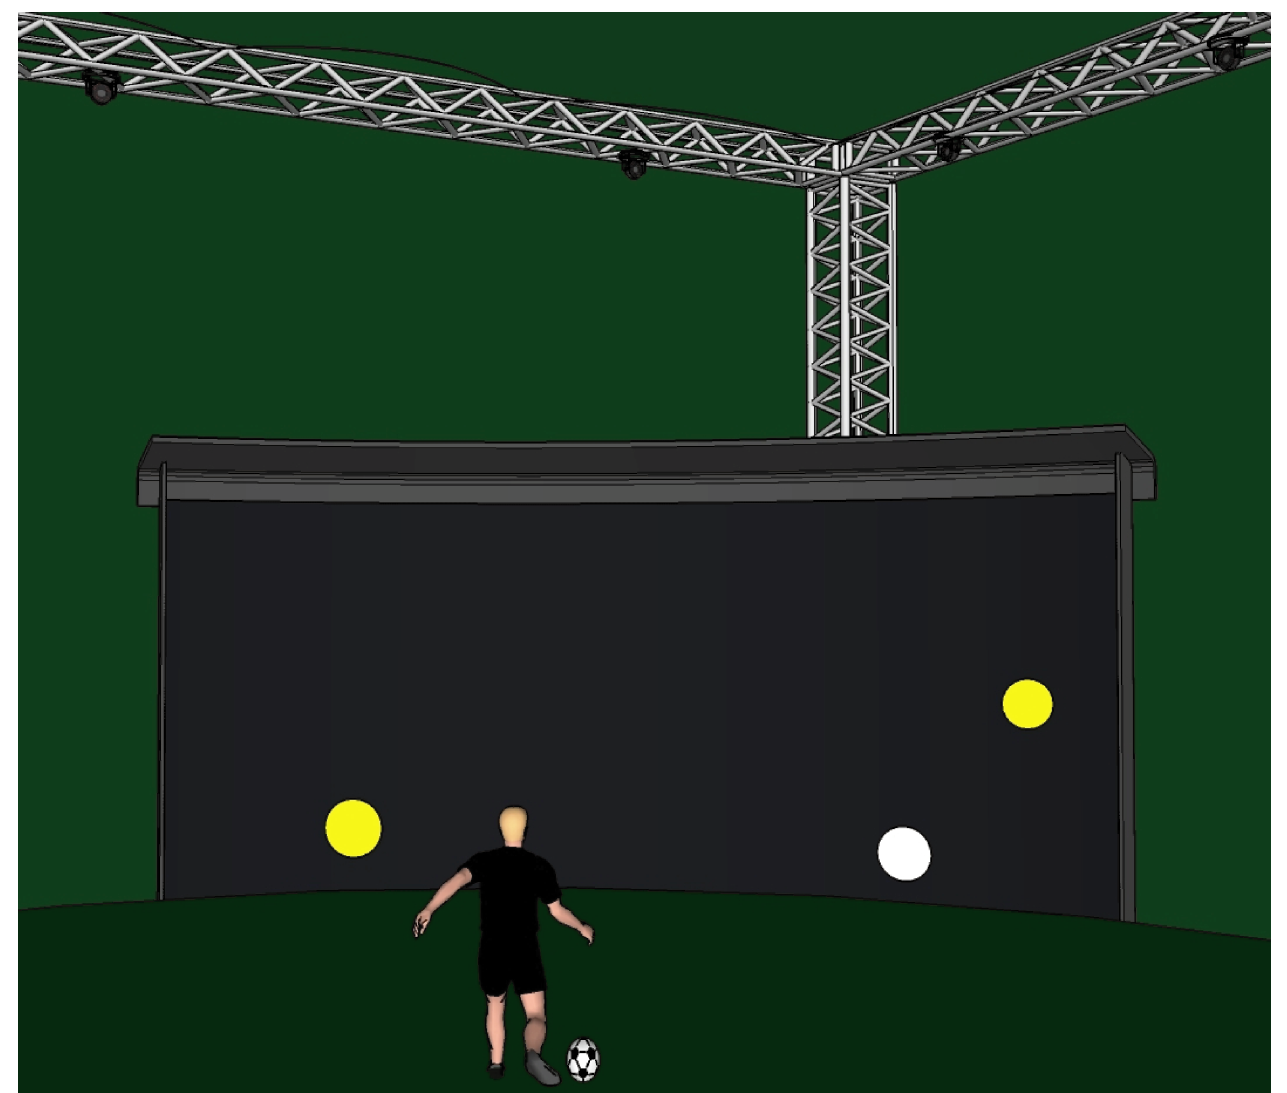
Fig 1. Illustration of the experimental set-up. The player passed the ball towards the white target which could appearat one of 9 randomly- generatedpositions(here the right-intermediateheight position). Visualdistractors (yellow circles) could appearrandomly on the screen together with the white target. The non-kicking foot had to remain within a black rectangledrawn on the artificial grass. Motion capture cameras were locatedabove the playerand tracked the ball movement in real-time. The videoprojector was placed behindthe playerat a height of 2.72 meters (not shown). Each player performed a total of 108 passes duringa test session (see text for details).